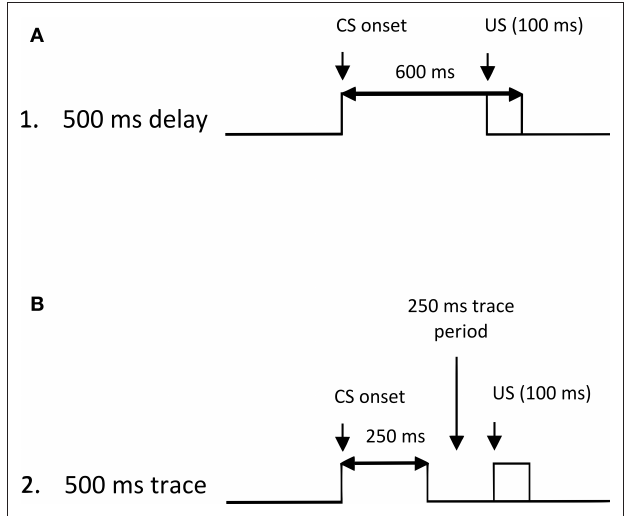
Figure 1 | illustration of the delay (A) and trace (B) eyeblink classical conditioning tasks used in the present study. The tasks were matched for the 500 ms interval between conditioned stimulus (CS) onset and unconditioned stimulus (US) onset. In delay conditioning, the CS precedes, overlaps, and coterminates with the 100 ms US. In trace conditioning, the CS precedes the US, but a 250-ms stimulus-free (trace) interval is imposed between the offset of the CS and the onset of the